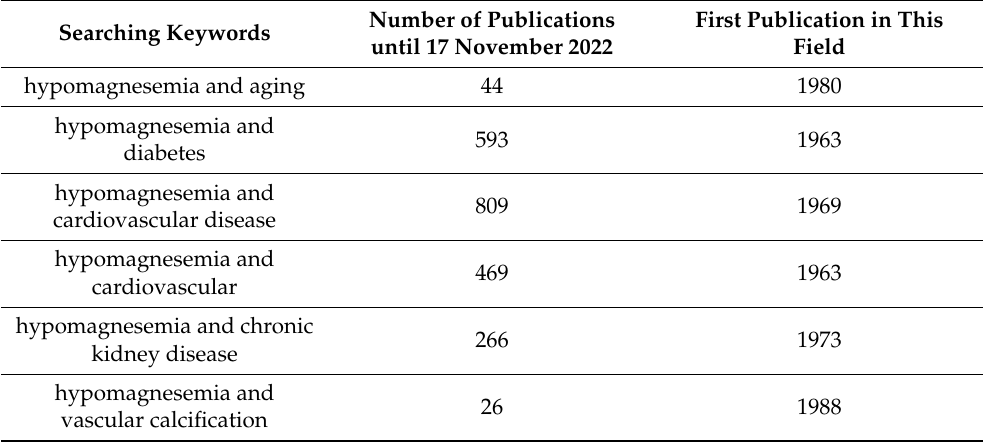
Table 2. The search results for the keywords “hypomagnesemia”, “aging”, “diabetes”, cardiovascular disease”, “cardiovascular”, “chronic kidney disease”, and “vascular calcification”.